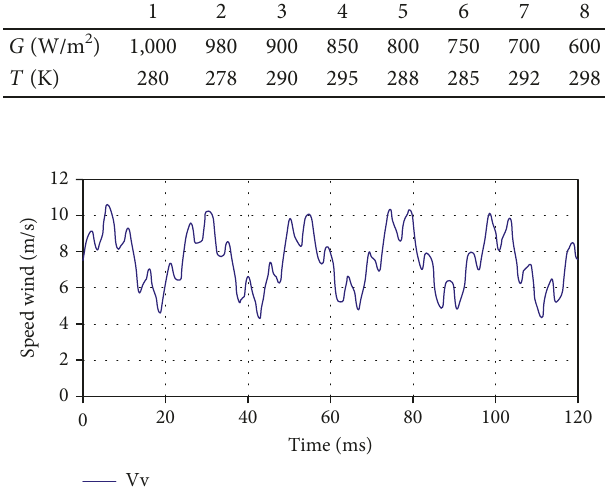
Figure 14: Allure of variable-speed wind